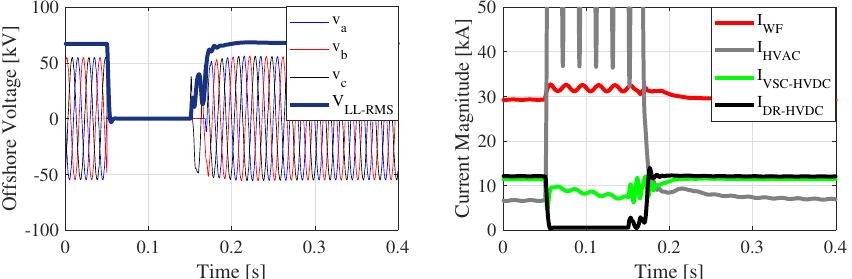
Figure 12. The voltage of offshore PCC ( left ) and currents ( right ) of OWF and transmission lines when a three-phase short-circuit occurs in offshore PCC.